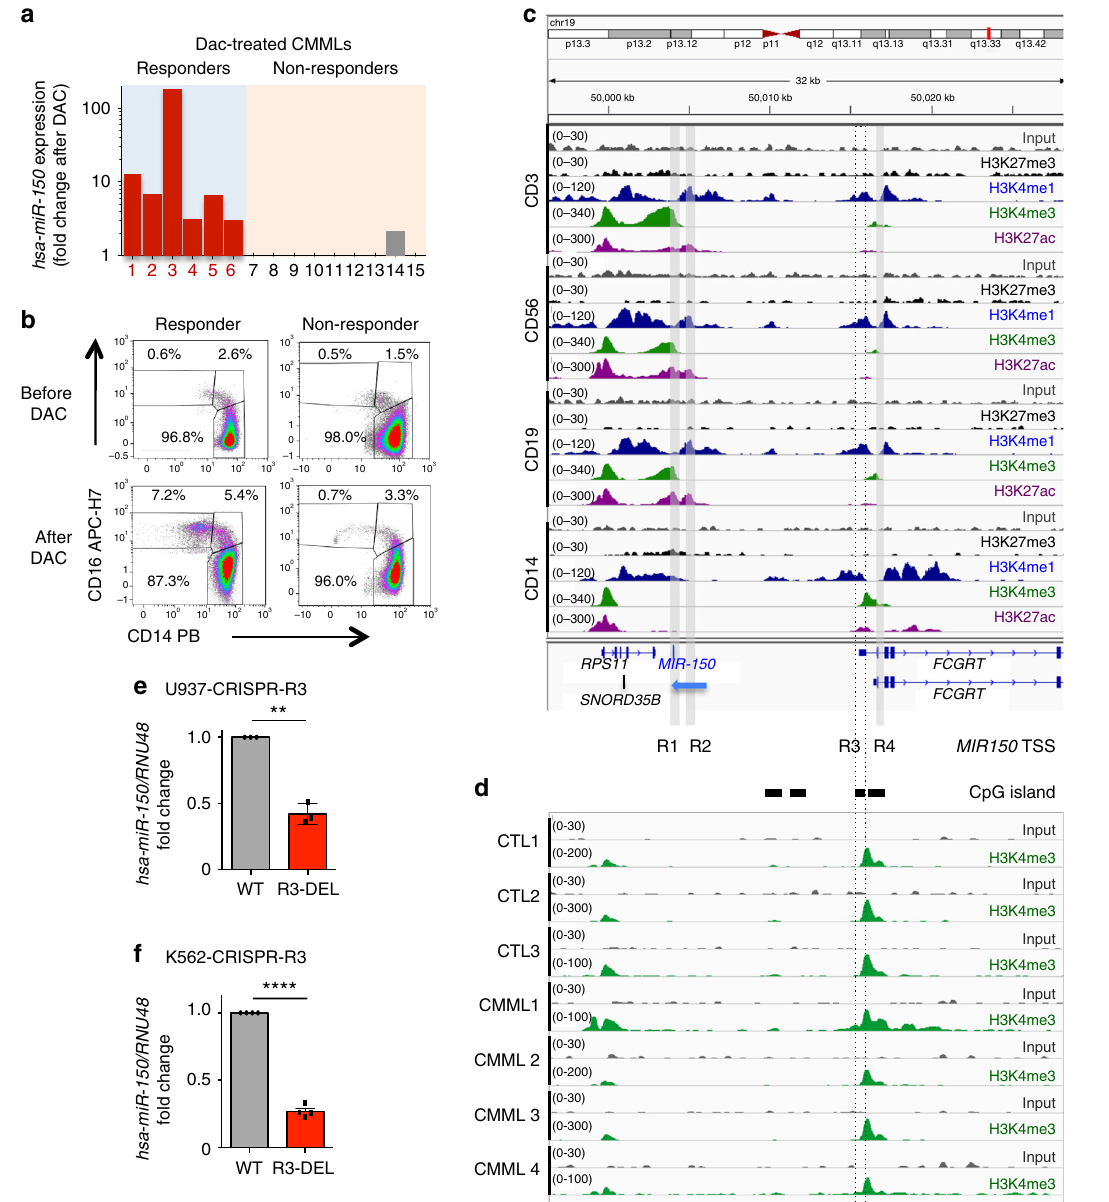
Fig. 5 Regulation of hsa-miR-150 expression by a monocytic lineage-speci fi c promoter. a Expression of hsa-miR-150 (normalized to RNU-6B ) in monocytes of 15 CMML patients according to their response to three to six cycles of decitabine (DAC). Results are expressed as hsa-miR-150 expression fold-change after versus before treatment. b Representative dot plots showing the monocyte subset repartition before and after treatment with decitabine (DAC) in a responder and a non-responder CMML patient. c Input (gray, scale 0 – 30) and ChIP-seq data for H3K27me3 (black, scale 0 – 30), H3K4me1 (blue, scale 0 – 120), H3K4me3 (green, scale 0 – 340) and H3K27ac (purple, 0 – 300) obtained in human CD3 + , CD19 + , CD56 + , and CD14 + cells were collected from www.roadmapepigenomics.org/. miR-150 promoters are indicated as R1, R2, R3, and R4. Black rectangles indicate CpG islands. MIR150 gene (blue) is on DNA minus strand (blue arrow), while other genes (in black) are on the DNA plus strand. d Input (gray) and ChIP-seq of H3K4me3 (green) in sorted CD14 + cells collected from three healthy donors (CTL) and four CMML patients. Data are shown as normalized Bigwig. Scales are on the left. e , f Expression of hsa-miR-150 (normalized to RNU-48) in U937 ( e ) and K562 ( f ) clones in which R3 has been partially deleted using a CRISPR/Cas9 gene editing method. Results are expressed as hsa-miR-150 expression fold-change in R3-deleted clone (R3-DEL, red bars) relative to wild-type clone (WT, gray bars, normalized to 1). Results are mean ± SD of a minimum of three independent experiments. Paired t test, ** P < 0.01; **** P <